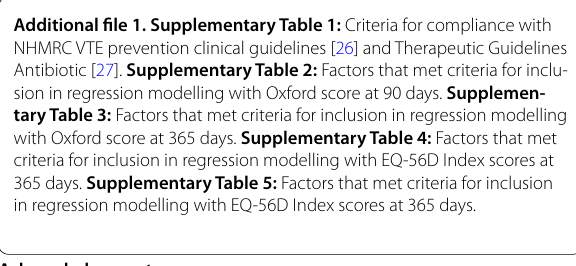
tary Table 3: Factors that met criteria for inclusion in regression modelling with Oxford score at 365 days. Supplementary Table 4: Factors that met criteria for inclusion in regression modelling with EQ‑56D Index scores at 365 days. Supplementary Table 5: Factors that met criteria for inclusion in regression modelling with EQ‑56D Index scores at 365